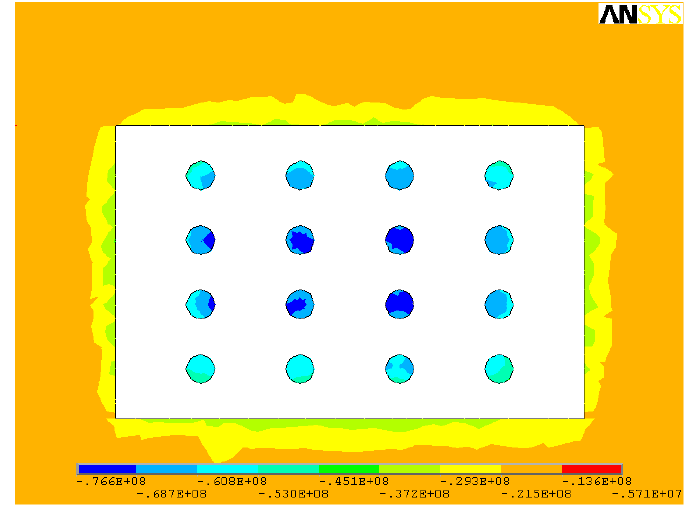
Figure 26. Minimum principal stress distribution in the middle of the pillar at 1480 mL of scheme 4 (parameters of scheme 4: stope height 3.5 m, pillar diameter 2 m, pillar spacing 5 m, pillar row spac- ing 8 m).